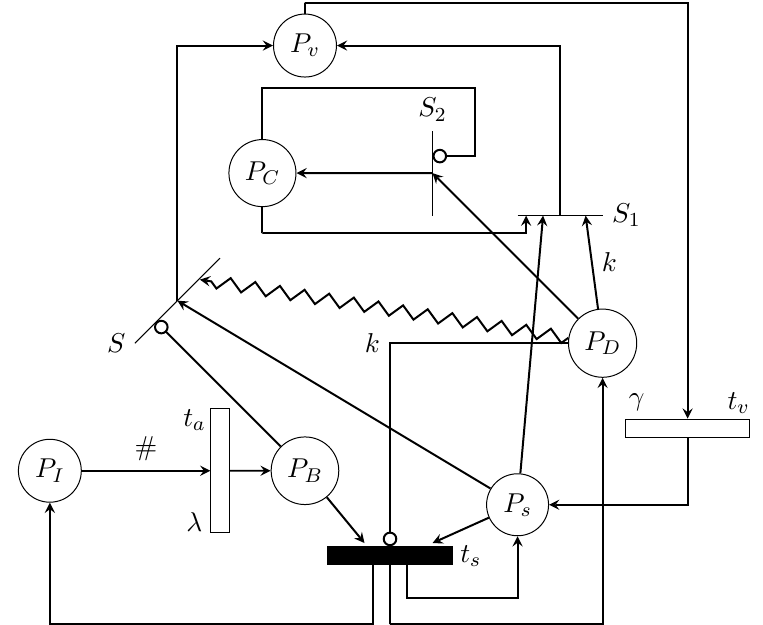
Figure 2: MRSPN model of the single vacation M/G/ 1 /N/V